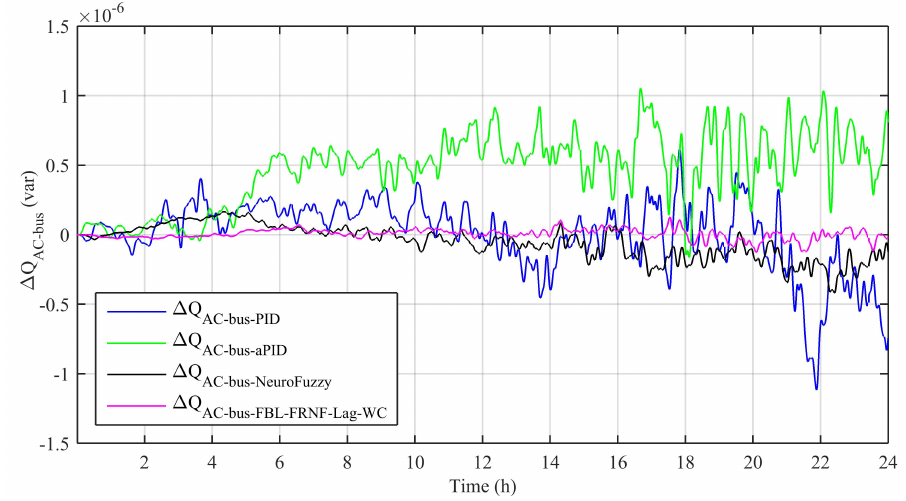
Figure 5. Net reactive power on the AC bus, ∆ Q AC .